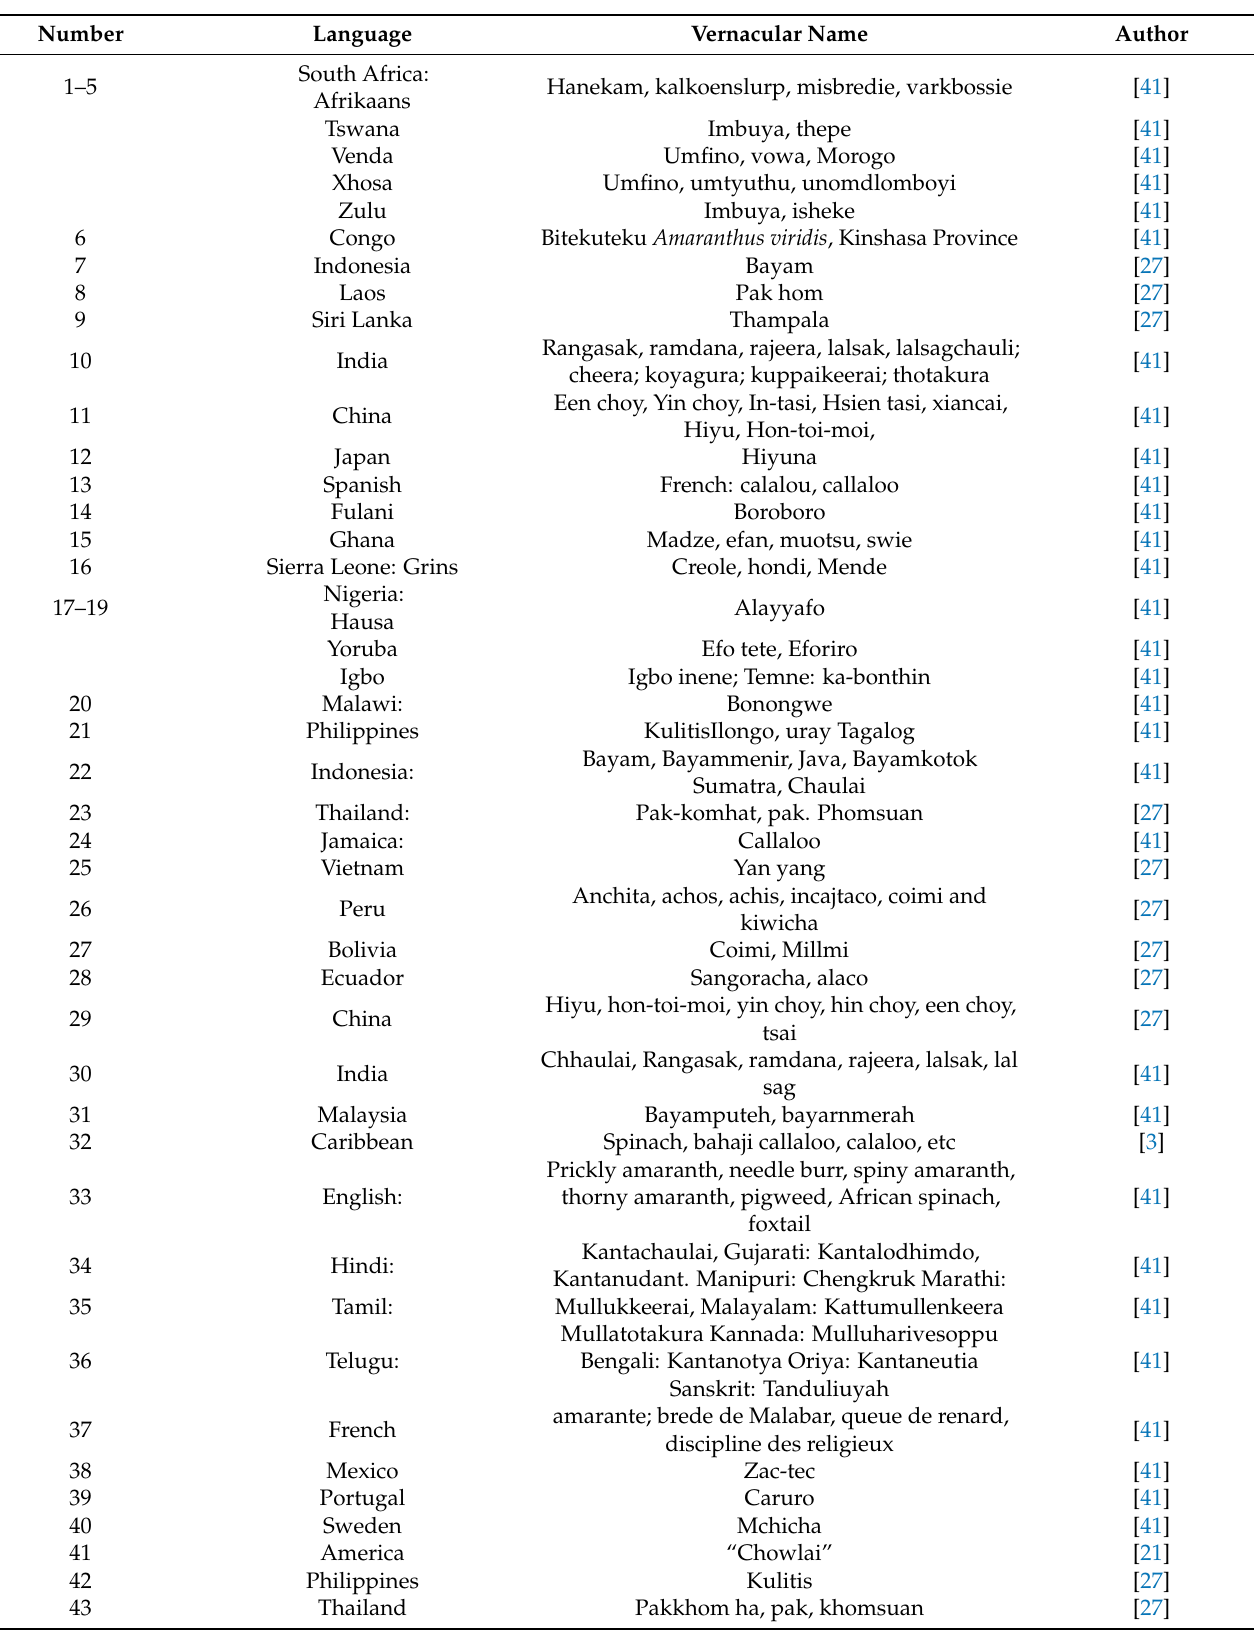
Table 2. Common names of Amaranth in different countries of the